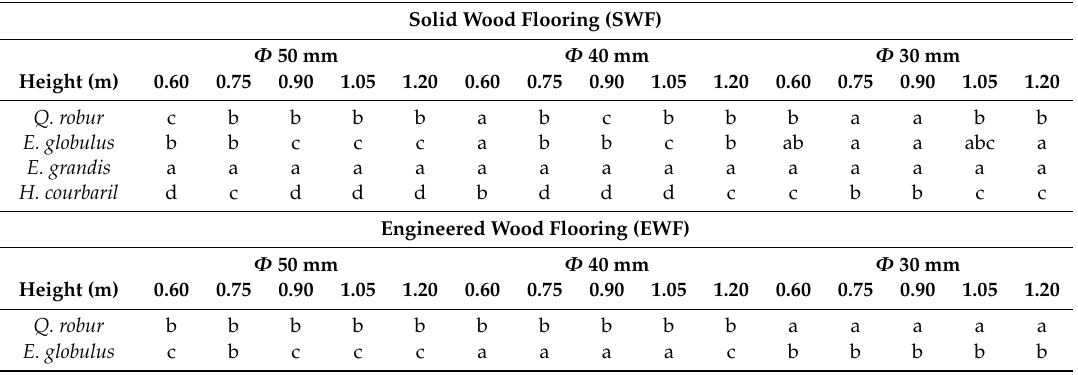
Table 8. Indentation depth (ID) pairwise comparison for specie per type flooring and height × ball. Solid Wood Flooring (SWF) Φ 50